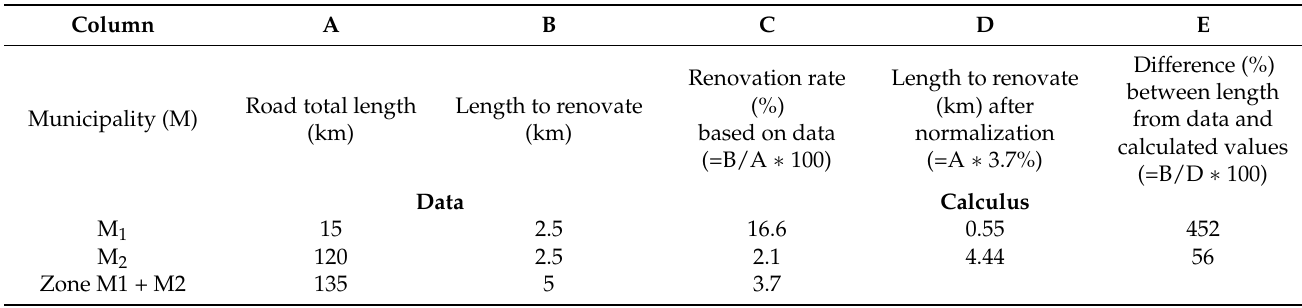
Table 2. A fictive example showing the difference (in %) between data and calculated values of a road length in two different municipalities (M1 and M2) when using the normalisation approach.